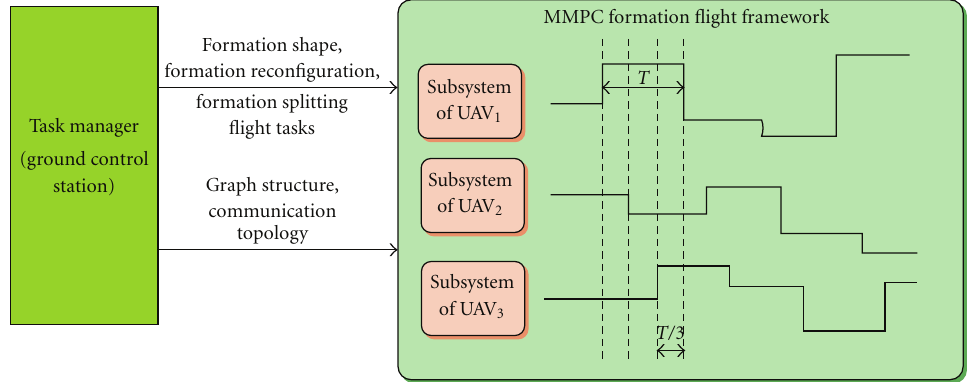
Figure 1: The overall formation flight control system under MMPC.